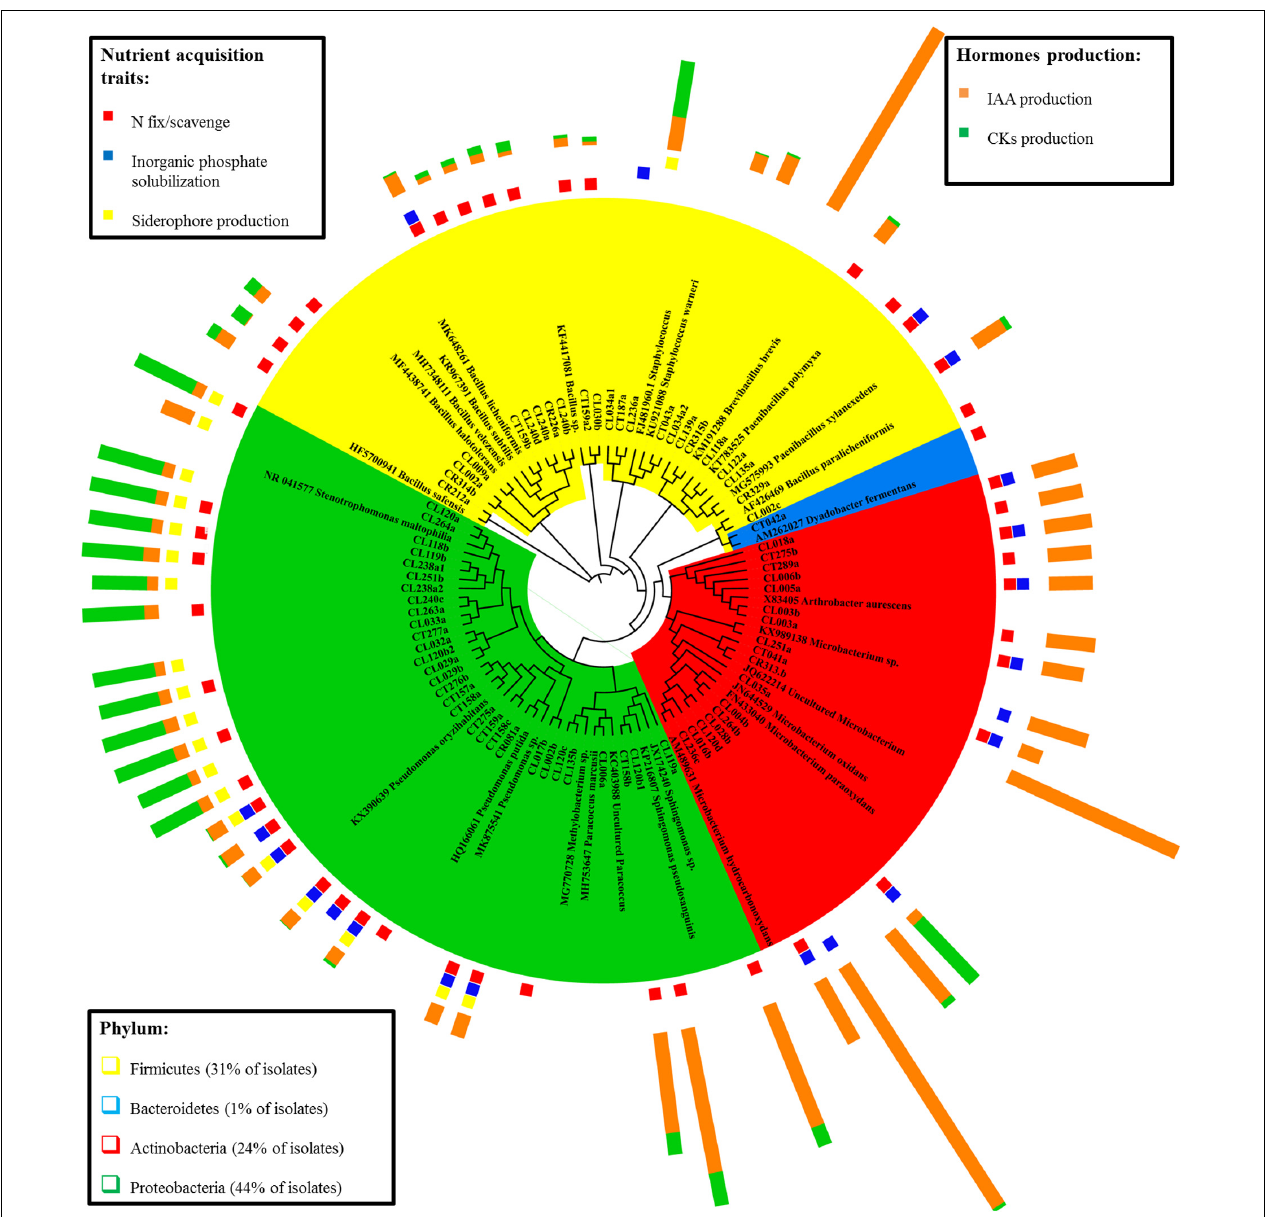
FIGURE 1 | Cladogram representing the identification of the endophytic bacterial isolates and the corresponding plant growth promotion traits. Isolates are grouped by their sequence similarity to the BLASTn reference sequence. Phylum taxonomic level is showed by color: Firmicutes (yellow), Bacteroidetes (blue), Actinobacteria (red), and Proteobacteria (green). Plant growth promotion traits are separated by nutrient acquisition traits (presence or absence) and hormone